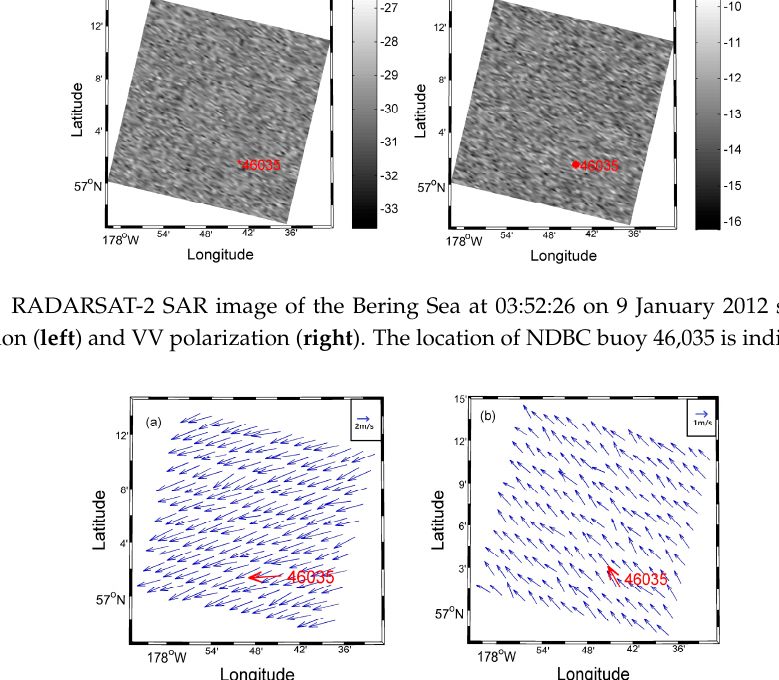
Figure 4. RADARSAT-2 SAR image of the Bering Sea at 03:52:26 on 9 January 2012 showing VH polarization ( left ) and VV polarization ( right ). The location of NDBC buoy 46,035 is indicated. The vector winds retrieved from the SAR images, U (cid:2903)(cid:2885)(cid:2902) (cid:4652)(cid:4652)(cid:4652)(cid:4652)(cid:4652)(cid:4652)(cid:4652)(cid:4652)(cid:4652)(cid:1318) , are decomposed in the Cartesian